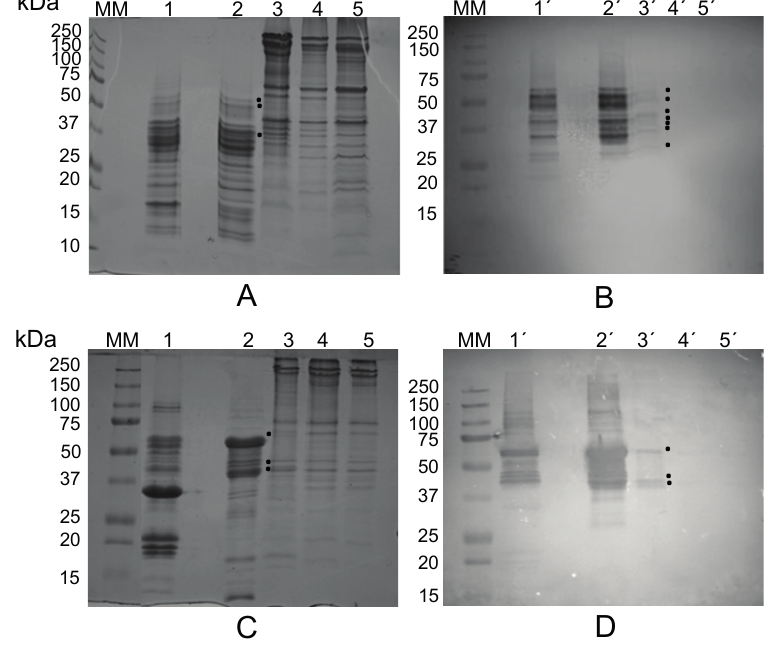
Figure 5. ( A ) Electrophoretic profile (R-SDS-PAGE) of total globulins from Lupinus albus seeds (lane 1) versus purified β -conglutin (lane 2). Incubation of erythrocyte membranes with β -conglutin, followed by R-SDS-PAGE and Coomassie Blue R staining revealed that at least three polypeptides bound to the membranes (lane 3). Lanes 4 and 5: initial membrane and final membrane, obtained before incubation and after elution with 0.4 M galactose, respectively; ( B ) An identical gel was blotted onto a nitrocellulose membrane and incubated with anti- β -conglutin antibodies; ( C , D ) Vicia faba electrophoretic study (R-SDS-PAGE) and immunodetection with anti- V. faba vicilin polypeptides, respectively, analogous to (A) and (B). Molecular masses of standards (MM) are indicated in kDa. Black dots indicate polypeptides bound to erythrocyte